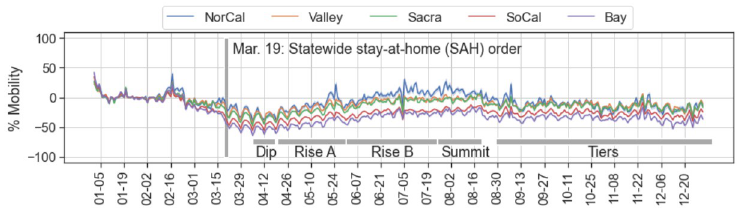
Fig 4. Regional median mobility. Mobility is the percentage of daily itinerancy change from a baseline established in January and February, and is calculated independently for each BG. The median mobility over all BGs in each region is shown here. Higher-population regions exhibit a more radical decrease in mobility than lower-population regions, a pattern that we later show repeats even in more granular clusters of